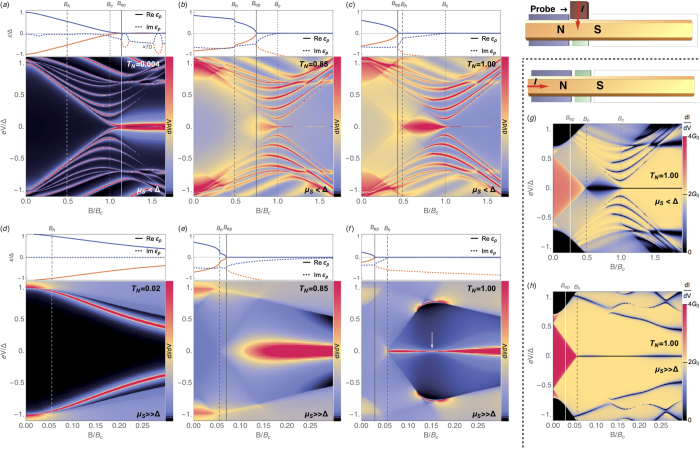
Signatures in dI/dV.(a–f) Tunnelling differential conductance dI/dV through a third probe contacted at the junction (brown in Fig. 3a), for different junction transparencies TN and for the same range of Zeeman fields B and bias voltages V. First row corresponds to μS = 0.5Δ, second row to μS = 10Δ, as in Fig. 3. The length of the proximitized wire is 1.5 μm. Evolution of lowest poles across a B = Bep exceptional point is shown atop each panel (higher poles not plotted for clarity). Note the sharp zero bias anomaly (ZBA) in the transparent, Andreev limit of panel (f), signalling the presence of MDSs in the topologically trivial regime Bh < B < Bc. (g,h) Differential conductance across the junction, for the same parameters as panels (c,f). The ZBA becomes a sharp dip on a constant 2G0 = 2e2/h background.